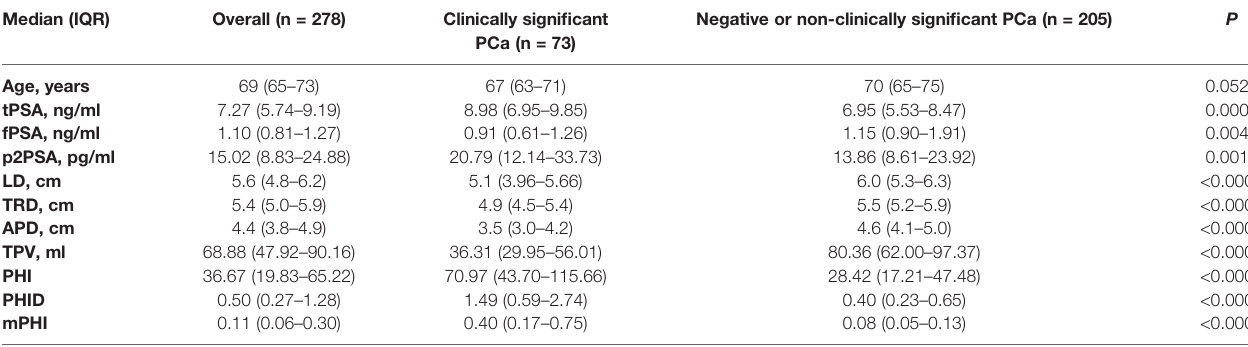
TABLE 1 | Clinical characteristics of the study cohorts within PSA gray zone.